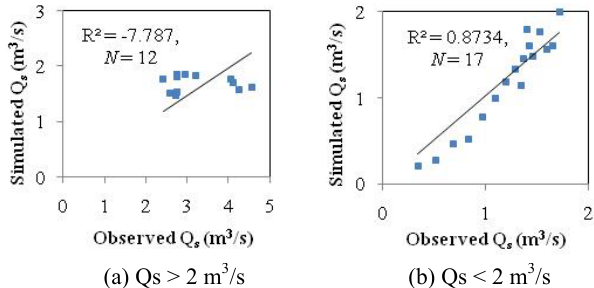
Fig. 11. Hourly suspended sediment discharge at Tateyama station (11 July 2002).